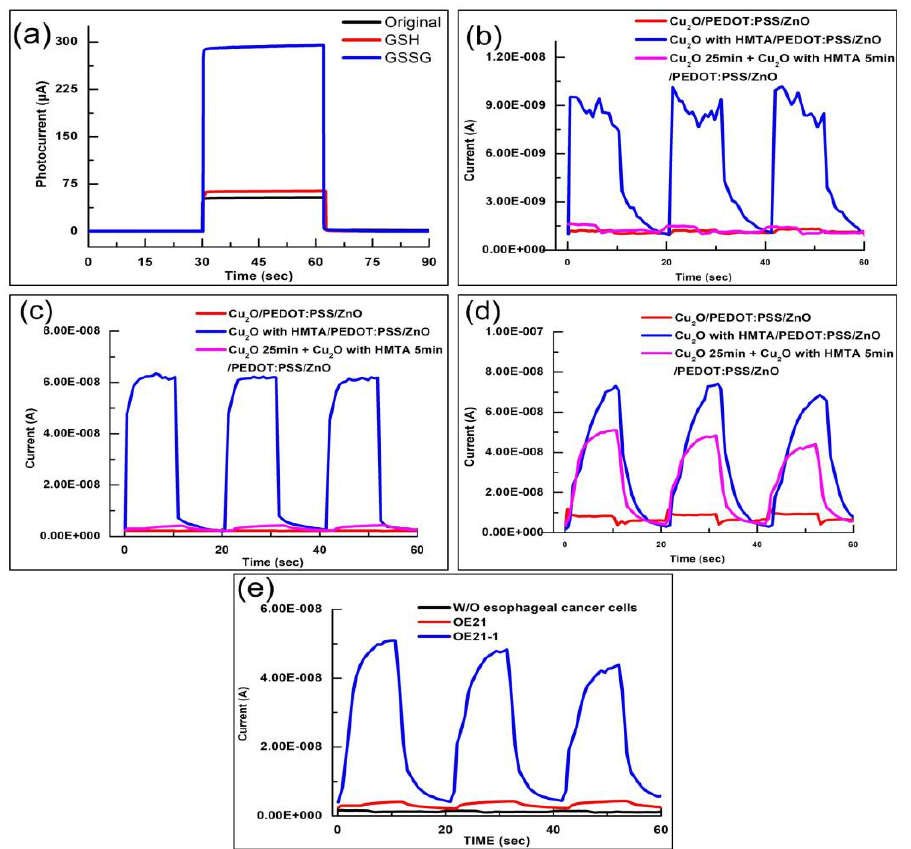
Figure 6. ( a ) Photocurrent responses of 100 μM GSSG, 100 μM glutathione (GSH), and pure PBS in 500 μL. Photocurrent response of biosensors to the following cells in 50 μL: ( b ) without esophageal cancer cells; ( c ) esophageal cancer cells (OE21); ( d ) esophageal cancer cells (OE21-1); ( e ) Cu 2 O 25 min + Cu 2 O with HMTA 5 min/PEDOT:PSS/ZnO shows considerable photocurrent response difference between OE21 and OE21-1. Cu2O with HMTA/PEDOT:PSS/ZnO presents high gain of 5.8 and 6.2 times in the detection of OE21 and OE21-1, respectively.